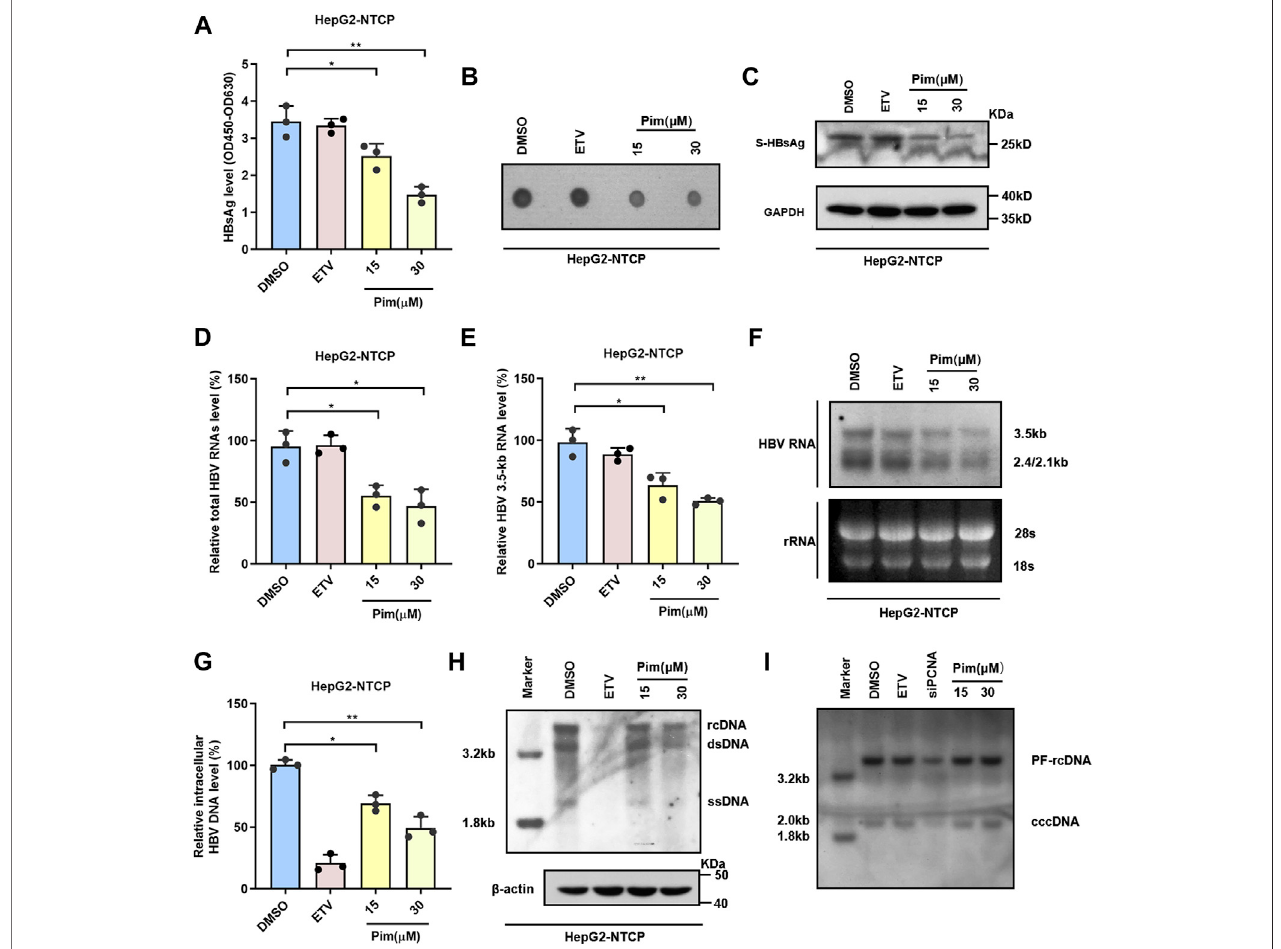
FIGURE 4 | Anti-HBV effects of Pim in HBV infection model (A) HepG2-NTCP was treated with 15 or 30 μ M Pim, 25 nM ETV as the positive control, and DMSO is negativecontrol.Pimtreatmentwasstarted72 hpostHBVinfection,andfurthertreatmentofPimfor6days.ELISAassaywasappliedtodeterminethesecretedHBsAg (B) The supernatant HBsAg level in HepG2-NTCP was determined by dot blot (C) Intracellular expression of HBsAg was con fi rmed by western blot in HBV-infected HepG2-NTCP (D – E) The total HBV RNAs and HBV 3.5-kb RNA were detected by real-time PCR after Pim treatment (F) HBV RNAs were analyzed by Northern blotting hybridization. Ribosomal RNAs (28S and 18S) served as loading control (G – H) The HBV core DNA in Pim treated HepG2-NTCP cells was observed by the quantitativePCRandsouthernblotting,respectively.Thelevelof β -actinwasusedasaloadingcontrolforHBVcoreDNA.rcDNA,relaxedcircularDNA.dsDNA,double- strand DNA. ssDNA, single-strand DNA (I) The cccDNA level after Pim treatment detected by Southern blot, siPCNA was used as a positive control for decreasing cccDNA (* p < 0.05; ** p < 0.01).